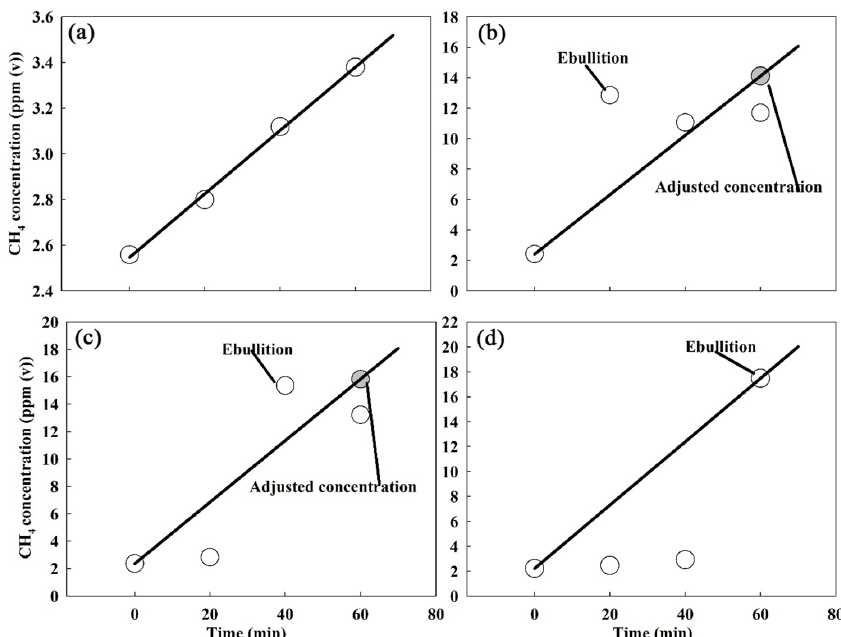
Figure 2. Examples of calculating the slope of total effluxes, including diffusive and ebullitive effluxes. All the concentrations are presented in original (volumetric parts per million units). White circles represent the CH 4 concentrations at different sampling times. Grey circles represent the adjusted concentration. Black trend lines represent the data used for the total efflux calculation. The different letters in the figure panels mean different occurrence times for ebullition: no ebullition (a) , occurrence of ebullition at 20min (b) , 40min (c) , and 60min (d)